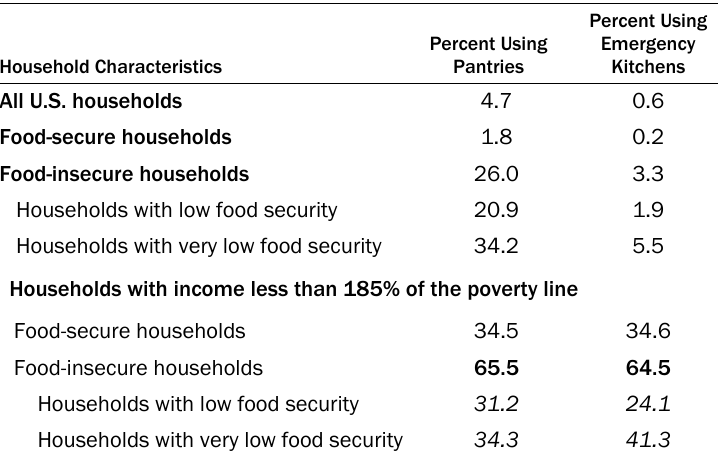
Table 1. Food Insecurity and the Use of Food Pantries and Emergency